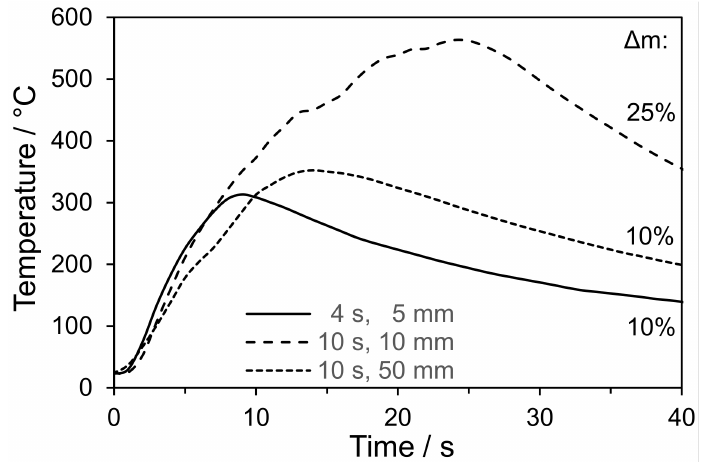
Figure 6. Temperature on the back side of samples with 0 ◦ fibre angle, during application of a propane flame for the given duration and distance between sample and welding gun, as well as corresponding mass loss ( ∆ m) after the experiment.